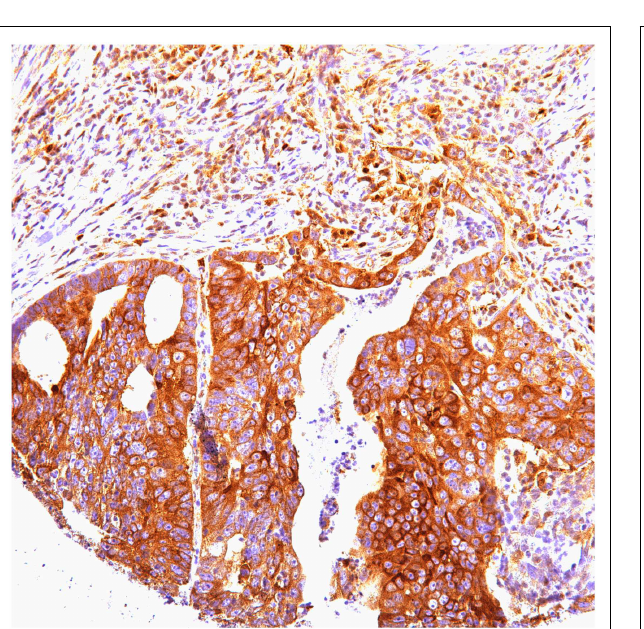
FIGURE 2 | Cytoplasmic positive in gastric carcinoma .